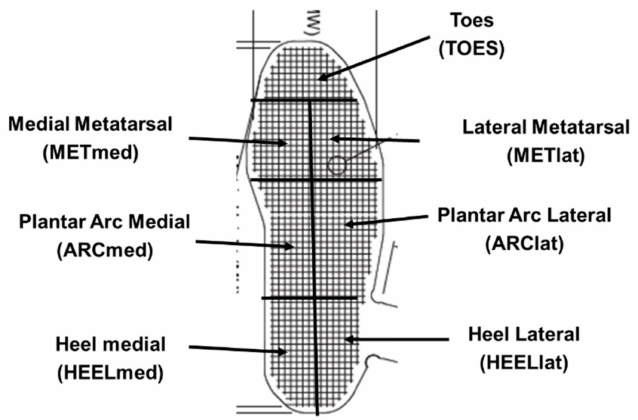
Figure 3. Seven Foot plantar areas defined for the statistical analysis: toes (TOES), medial metatarsal (METmed), lateral metatarsal (METlat), plantar arc medial (ARCmed), plantar arc lateral (ARClat), heel medial (HEELmed), and heel lateral